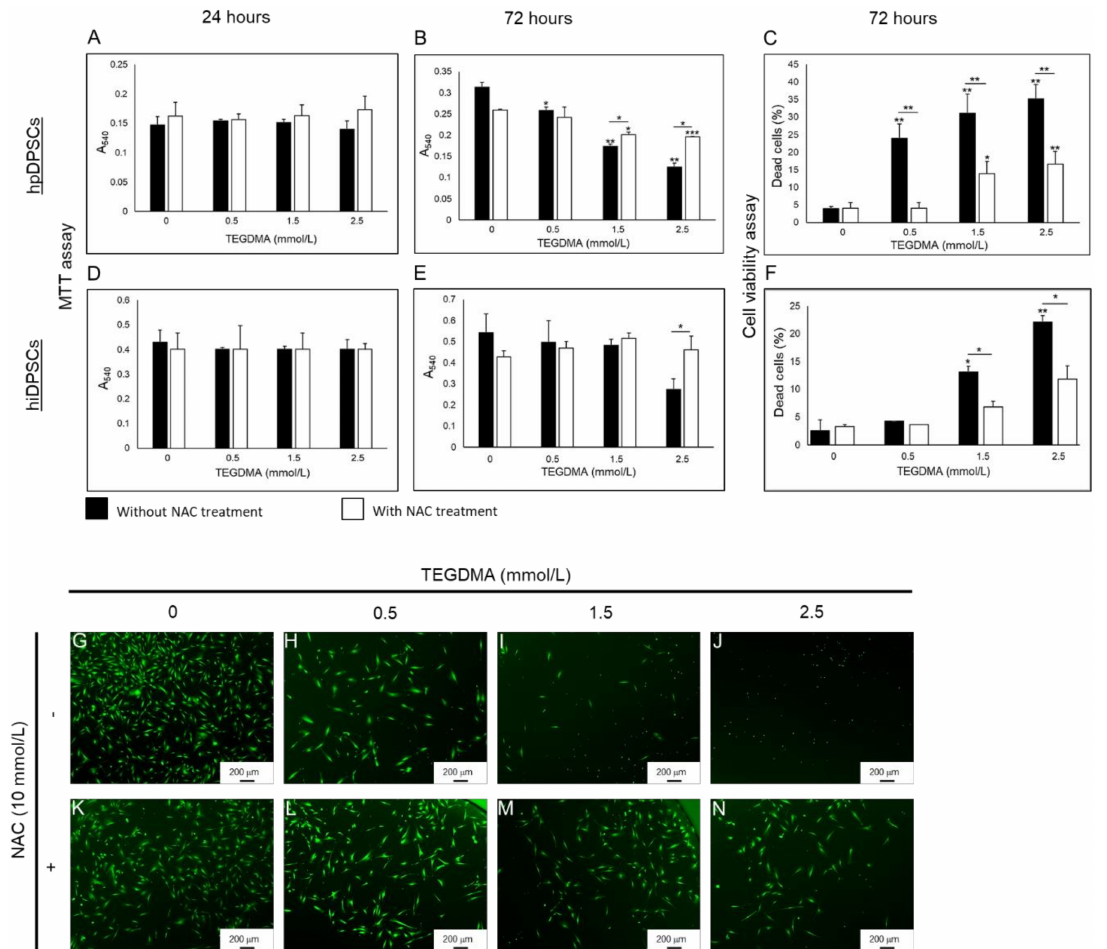
Figure 1. Viability and proliferative capacities of dental pulp cells exposed to TEGDMA and treated with NAC. ( A – F ) Bar graphs compare the relative quantities of viable metabolically active ( A – C ) hpDPSCs and ( D – F ) hiDPSCs. Cell proliferation is determined at 0, 0.5, 1.5, and 2.5 mmol / L TEGDMA after ( A , D ) 24 h, and ( B , E ) 72 h via MTT analysis. ( C , F ) Viability is determined by using live staining and calculating the percentage of dead cells after 72 h of incubation. * p ≤ 0.05, ** p ≤ 0.01, *** p ≤